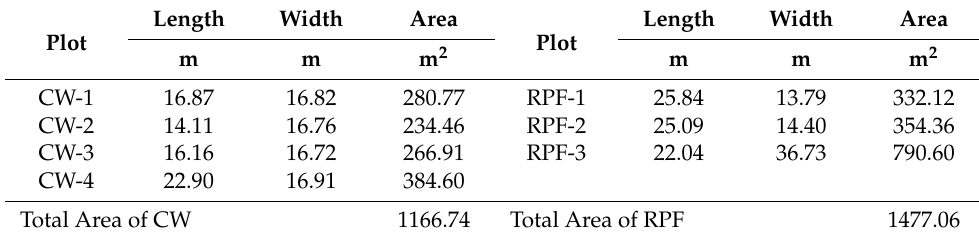
Table 1. Length, width and area of each plot of CW and RPF treatments.